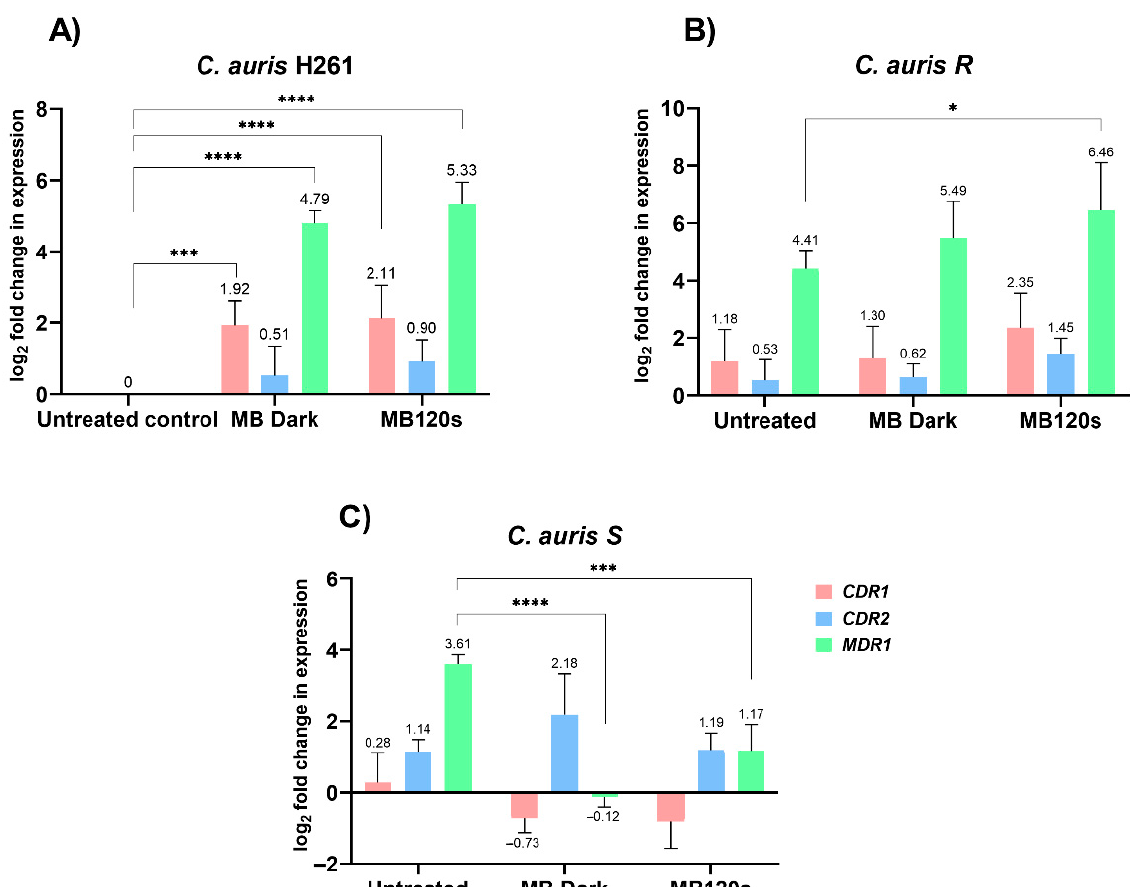
Figure 4. Log 2 fold change in expression of CDR1 , CDR2 , and MDR1 genes in 24 h biofilms of sensitive strain C. auris H261 ( A ) and resistant strains of C. auris R ( B ) and C. auris S ( C ). The expression of genes was normalized to the housekeeping gene ACT1 . The untreated control was a 24 h biofilm without MB of C. auris H261, set to a value of 1 for all tested genes, and all respective values were calculated relative to this value. The untreated groups were a 24 h biofilm without MB, the MB Dark group was incubated with 0.25 mM MB, and MB 120 s was the group treated with 0.25 mM MB and irradiated for 120 s. The results were considered to be significant at different p -values: p < 0.05 ( ∗ ), p < 0.01 ( ∗∗ ), p < 0.001 ( ∗∗∗ ) and p < 0.0001 ( ∗∗∗∗